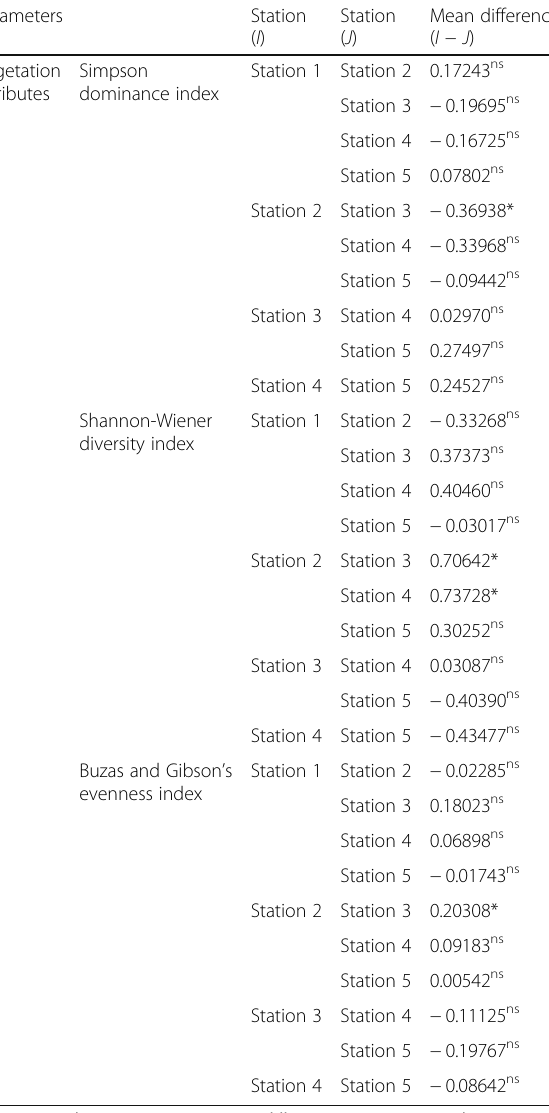
Table 3 Multiple comparisons of vegetation attributes in the wetland at different sampling stations using Tukey Post-hoc analysis